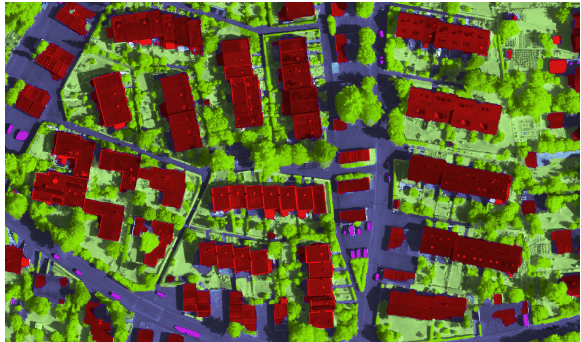
Figure 1: Class map estimated with the proposed ensemble of fully convolution networks (FCNs), over a scene taken from un- labelled official ISPRS Vaihingen dataset. Visualization is color coded, red color depicts buildings , dark green depicts trees , light green depicts low-vegetation , blue depicts impervious-surfaces and purple depicts cars